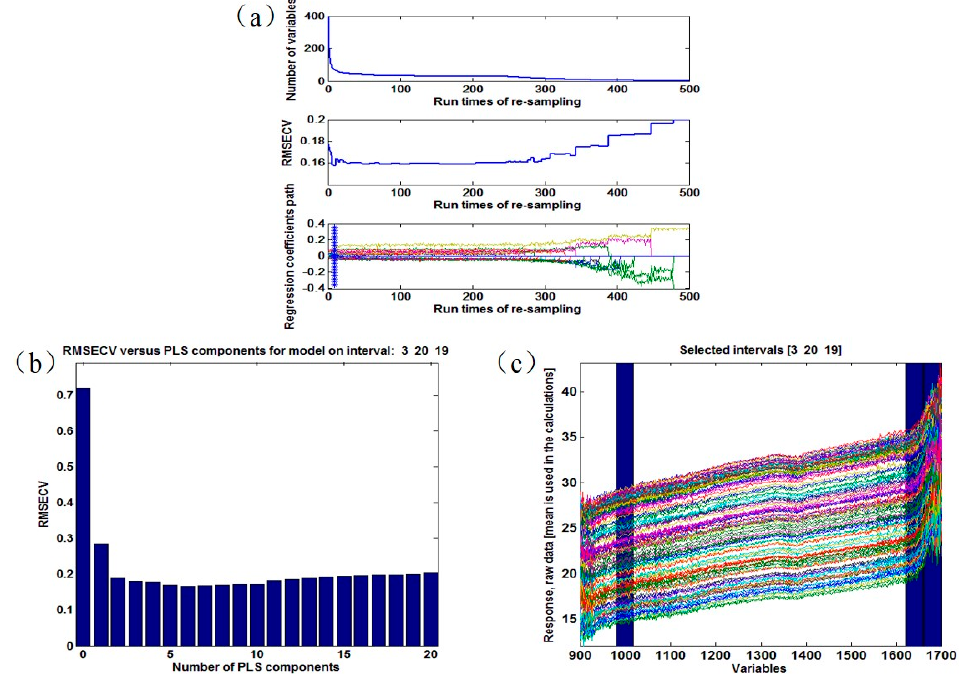
Figure 4. The sensitive waveband selection process: ( a ) The characteristic variables selected by the competitive adaptive reweighted squares (CARS); ( b ) the number of PLS components and the corresponding the root mean square error of cross validation (RMSECV) values while running Backward Interval Partial Least Squares (BIPLS); ( c ) the characteristic intervals determined by BIPLS.